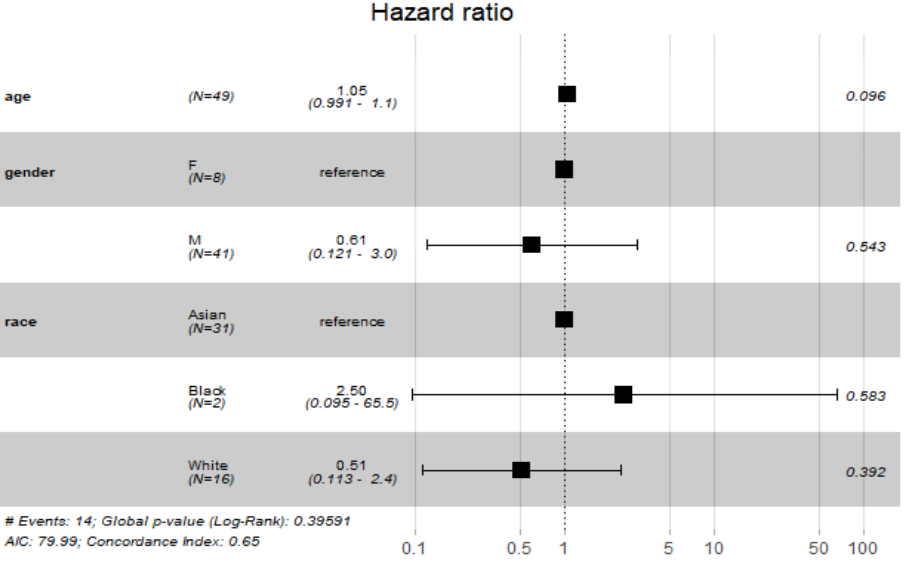
Figure 2. Cox proportional hazard model with demographic characteristics. 2.2. Classification of Patients before and after Treatment according to WHO